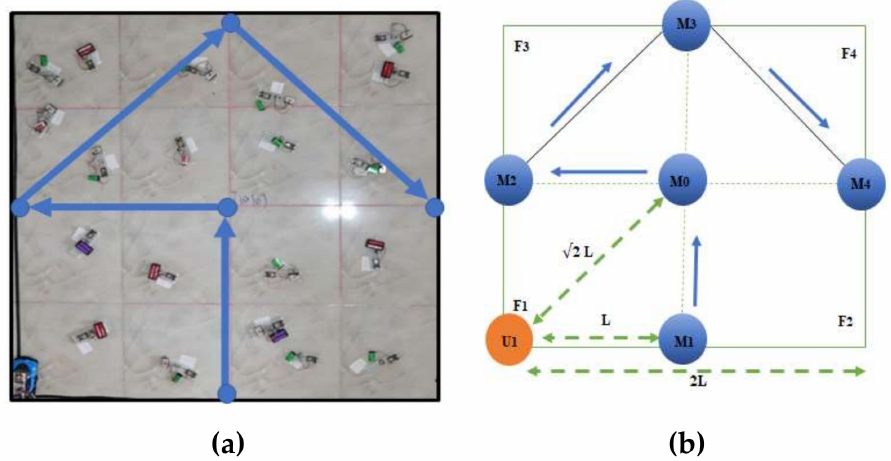
Figure 7. ( a ) Applied Arrow-Curve path model; ( b ) Arrow-Curve path model (le = 1).